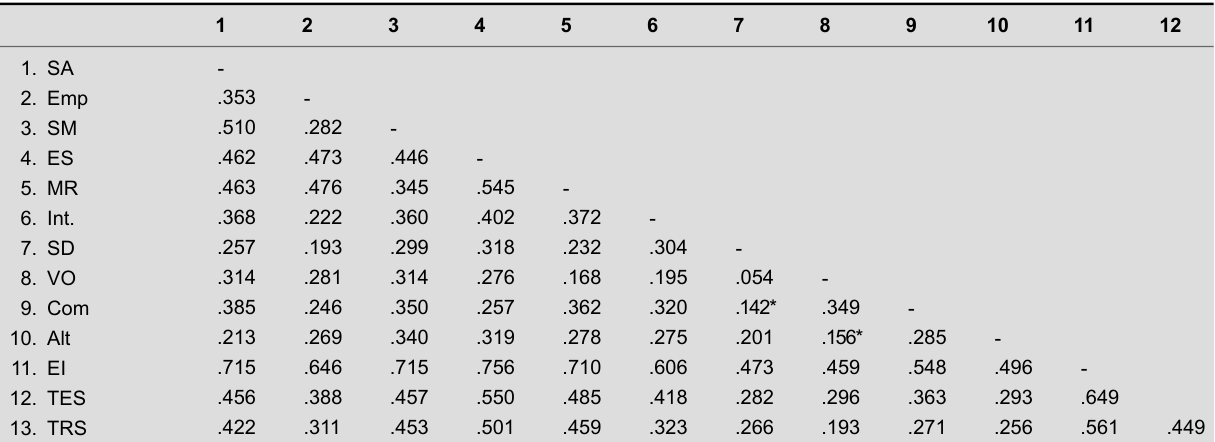
Inter-Item Correlation for Variables Under